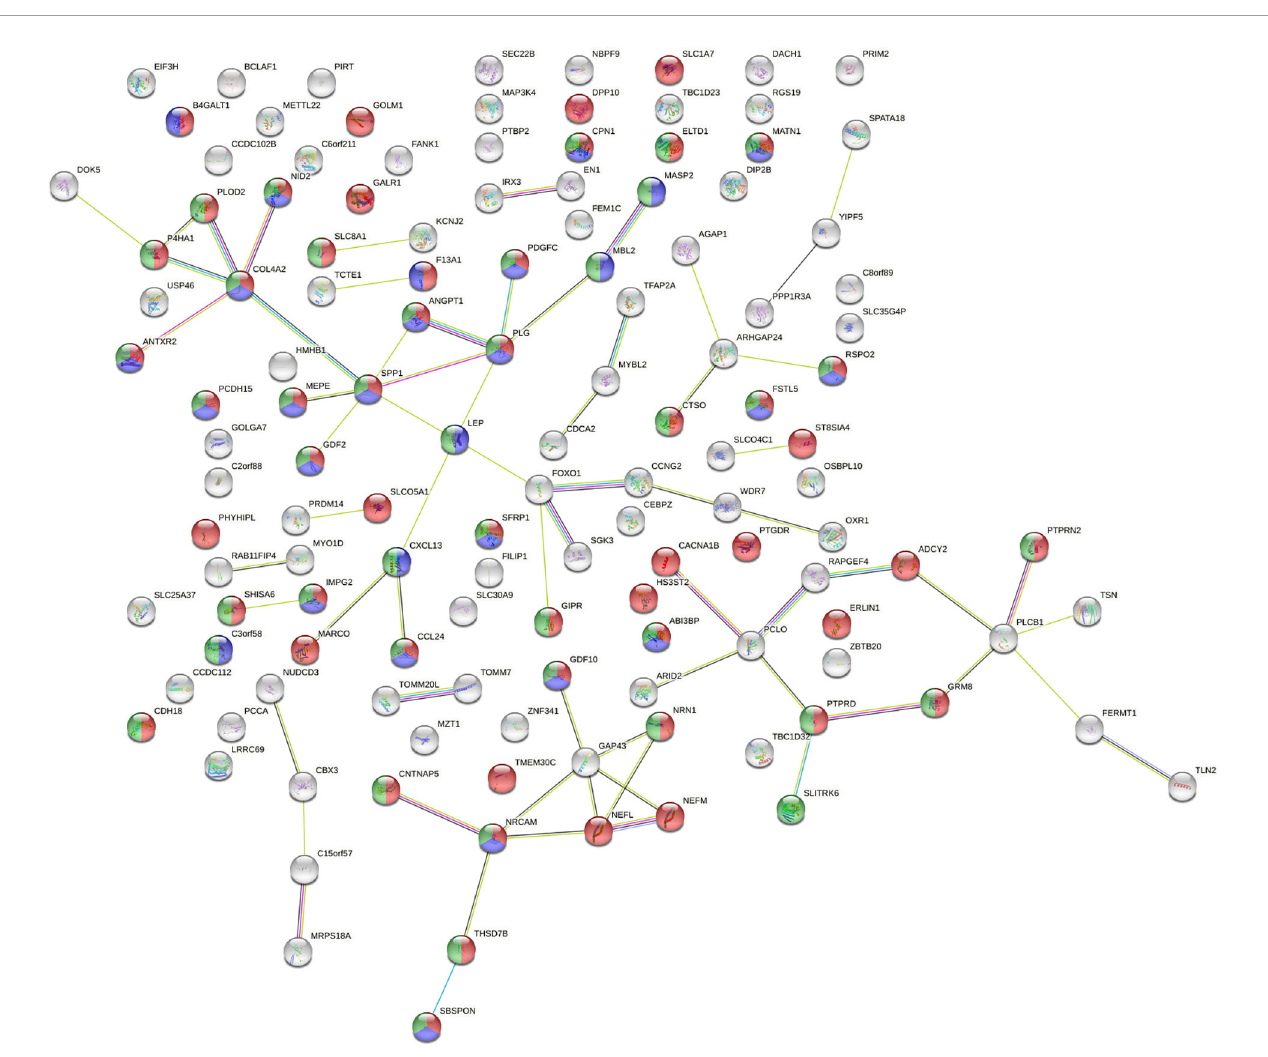
FIGURE 3 Analysis of protein-protein interaction network (PPI) affected by SVs. The number of nodes was 130, with each node representing a protein, 53 red nodes representing glycoproteins, 41 green nodes representing cell signal transduction, and 28 blue nodes representing secretory proteins. There were a total of 68 lines between nodes, each line representing the interaction between two proteins. Red line – gene fusion, green line – gene neighborhood, blue line – gene co-occurrence, purple line – experimentally determined, yellow line – textming, light blue line – from curated databases, black line – co- expression. PPI enrichment P = 1.57x10 -4